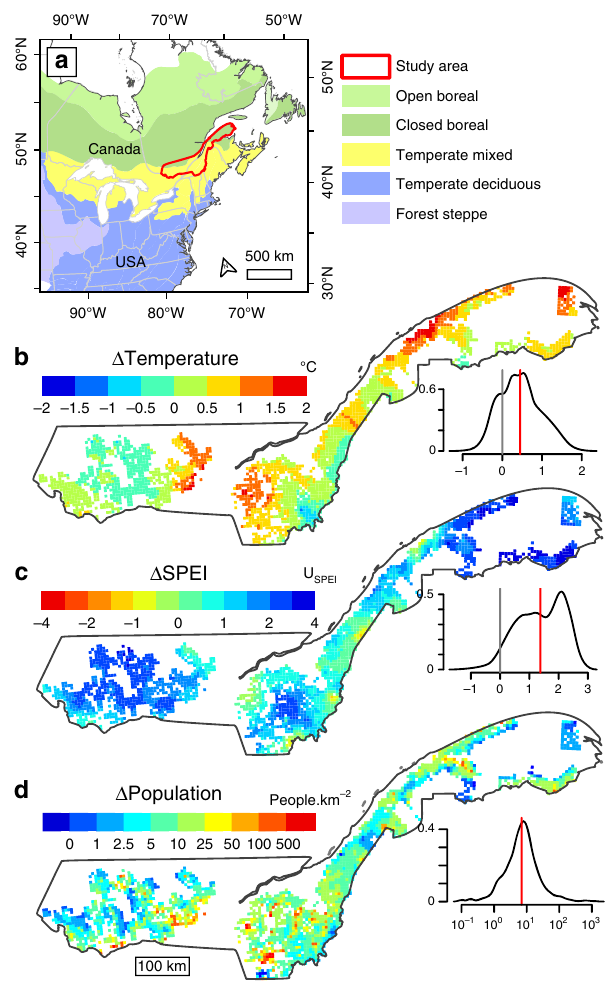
Fig. 1 Changes in temperature, moisture and population. Location of the study area ( a ), and changes from 1901 to 1980 in mean annual temperature ( Δ Temperature; b ) and in the standardized precipitation evapotranspiration index ( Δ SPEI; c ) and changes in population density since 1831 ( Δ Population; d ); see Methods for a description of data sources. SPEI is based on the difference between monthly precipitation and potential evapotranspiration, and negative values of Δ SPEI indicate an increase in drought, while positive values indicate an increase in moisture. Change in population density was calculated as the difference between population density in 1831 and the highest population density recorded since the end of the nineteenth century. Smoothed distributions are shown next to each map (vertical gray and red lines show 0 and mean values, respectively, and Δ Population was